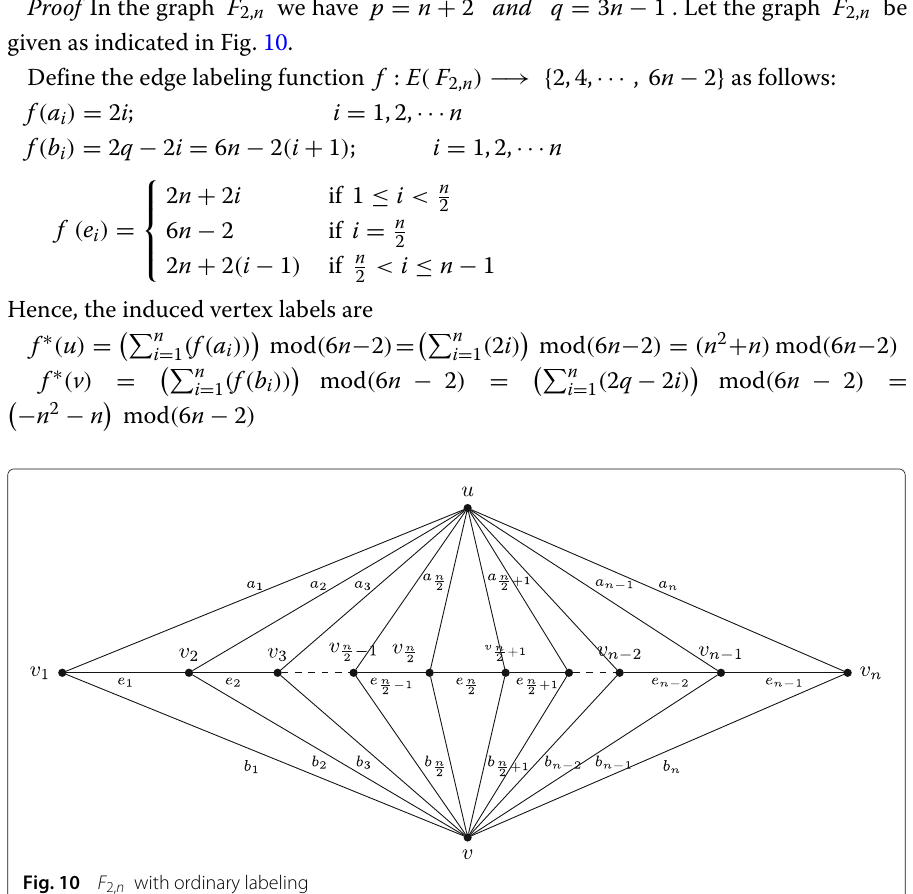
Fig. 10 F 2, n with ordinary